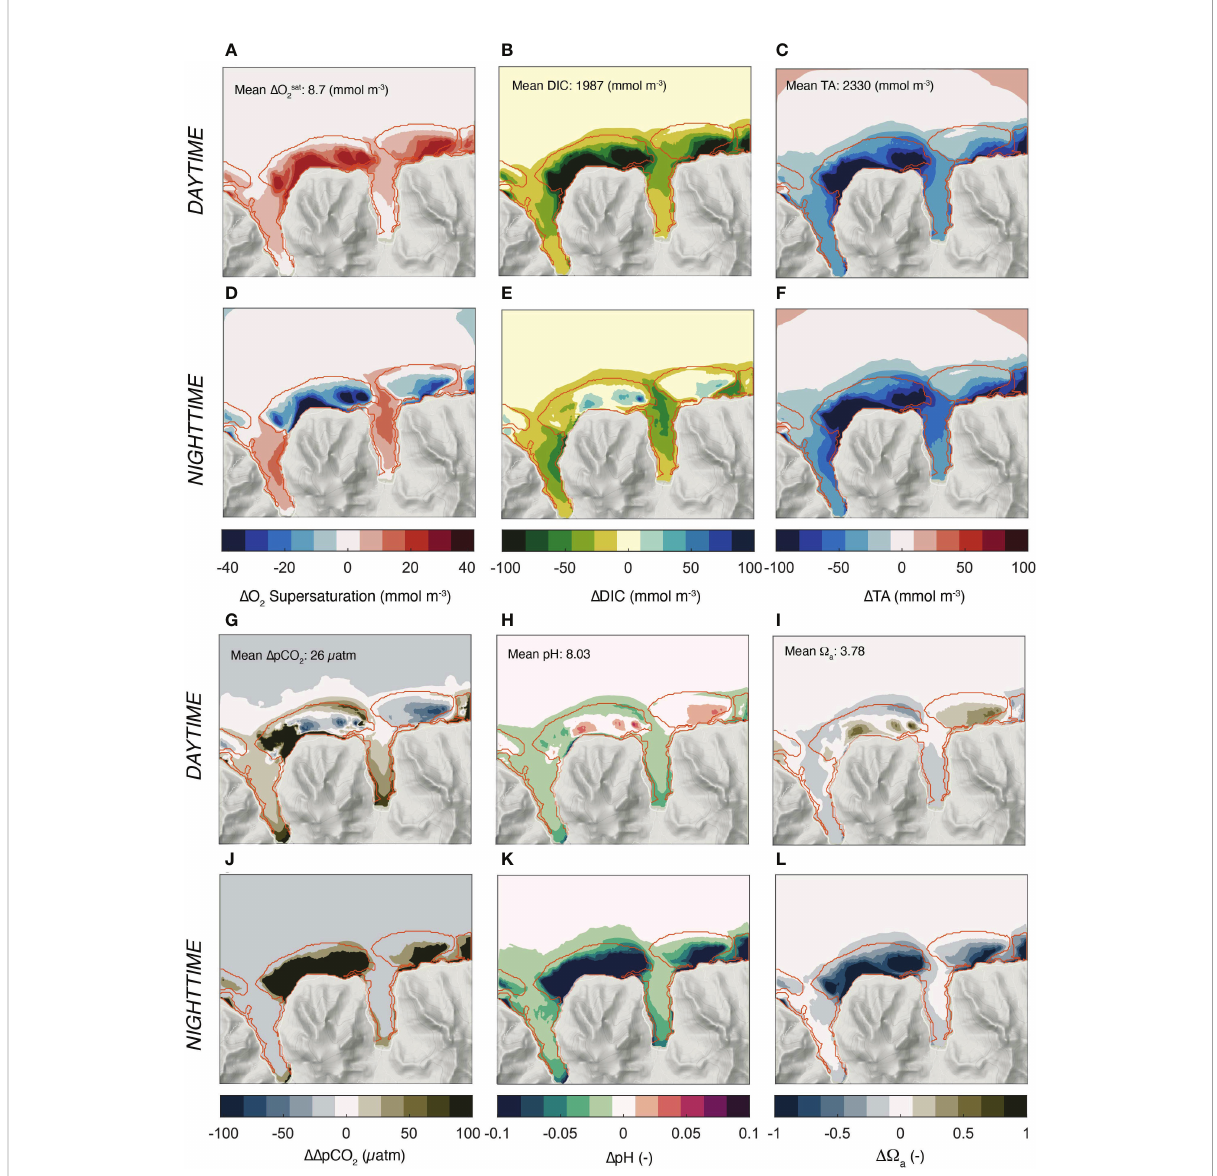
FIGURE 7 Simulated day and night distribution of oxygen and the parameters of ocean carbonate system relative to the open ocean. (A-C) and (G-I) depict the annual mean concentrations for the day hours, while (D-F) and (J-L) the same properties for the night hours. (A, F) Surface O 2 supersaturation, i.e., [O 2 ] - [O 2 ] sat , (B, E) DIC, (C, F) Total Alkalinity (TA), (G, J) surface D ; p CO 2 = p CO 2 - p CO 2 atm, (H, K) pH, and (I, L) Ω a , the saturation state with respect to aragonite. Also shown in (A – C) and (G-I) are the mean values for the open ocean. The daytime hours comprise 08:30 to 15:30, and the nighttime hours comprise the average of 21:30 and